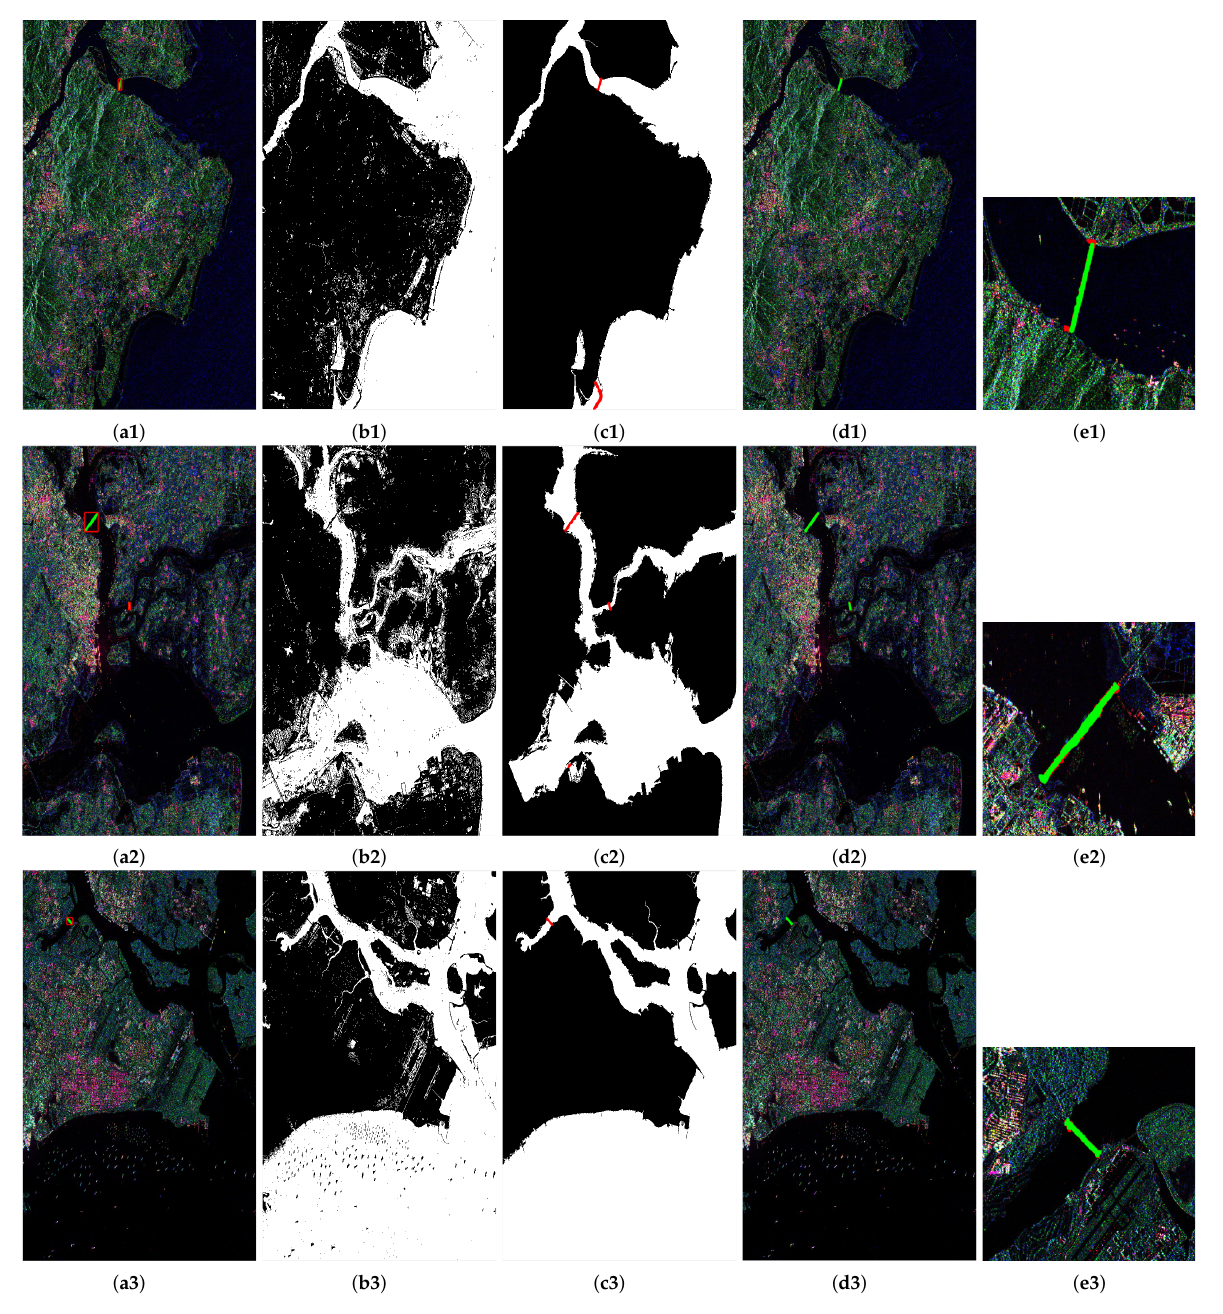
Figure 5. Comparison of detection results of sea-crossing bridges under different scenarios. ai-ei are the results of RADARSAT-2 polarimetric SAR data in Fuzhou, Fujian, Zhanjiang, Guangdong, and Singapore, respectively. ( a1 – a3 ) The Pauli pseudo-color images and the ground-truth of bridges. ( b1 – b3 ) Sea–land segmentation results. ( c1 – c3 ) Water merging results, where the red pixels are the bridge regions detected by Algorithm 3. ( d1 – d3 ) The bridge results recognized by the censoring of H / α . ( e1 – e3 ) The enlarged results of the region near the sea-crossing